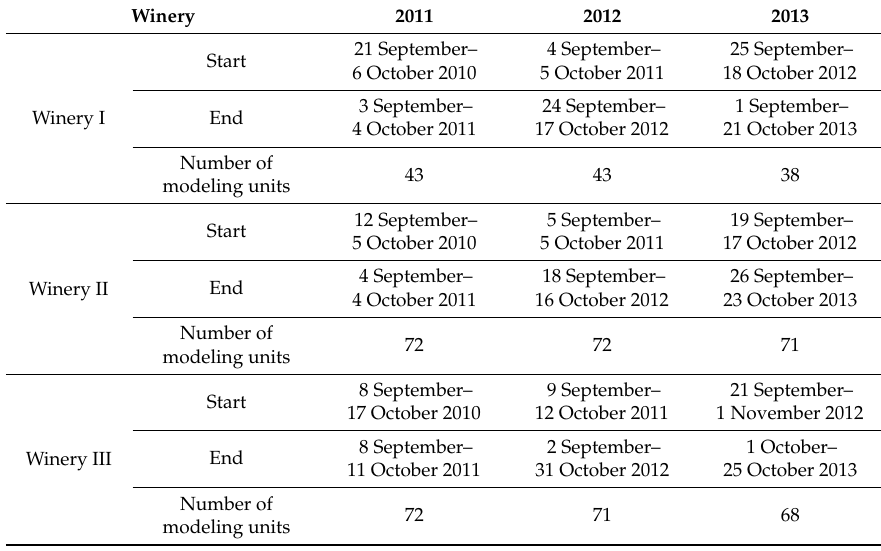
Table 3. The timeframe of the modeling start (one day after harvest in the previous year) and modeling end (day of harvest in the current year). Some modeling units had different start and end dates. The number of modeling units matches the number of vineyard